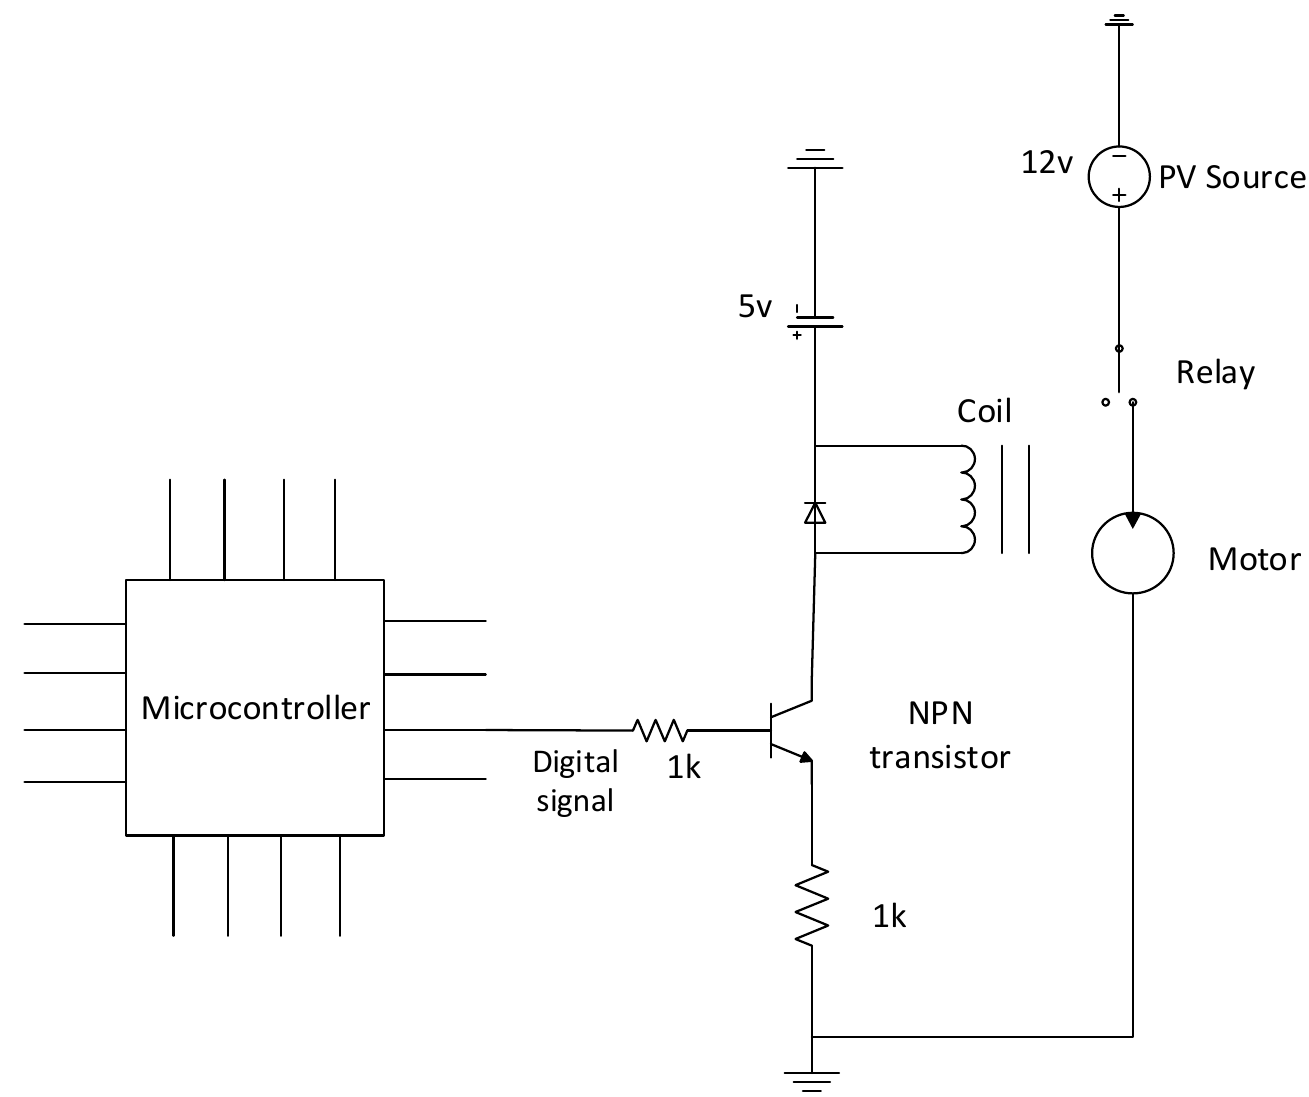
Figure 8. Motor switching circuitry for smart-sensors-based solar-powered system.